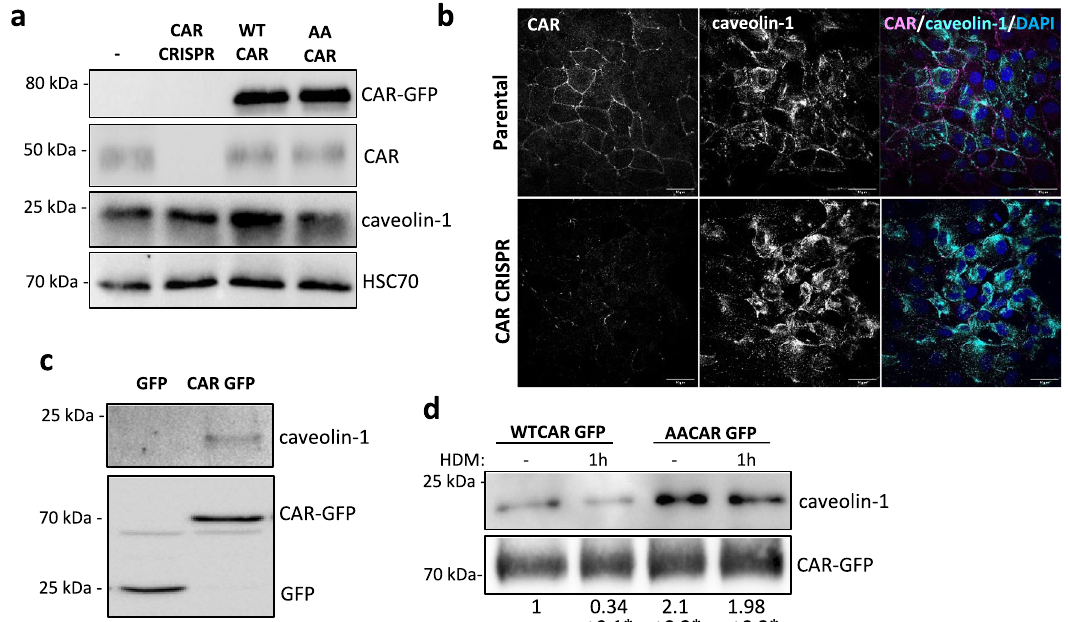
Fig. 5 | CAR forms a complex with caveolin-1. a Lysates from 16HBE parental, CRISPR, CAR-GFP and AACAR-GFP cells probed for GFP, CAR, caveolin-1 and HSC70. Representative of 3 independent experiments ( b ) Confocal images of 16HBE parental and CAR CRISPR cells fi xed and stained for CAR (magenta), caveolin-1 (cyan) and DAPI (blue). Scale bars: 50mm. c Lysates from 16HBE cells expressing GFP or CAR-GFP were subjected to GFP-trap